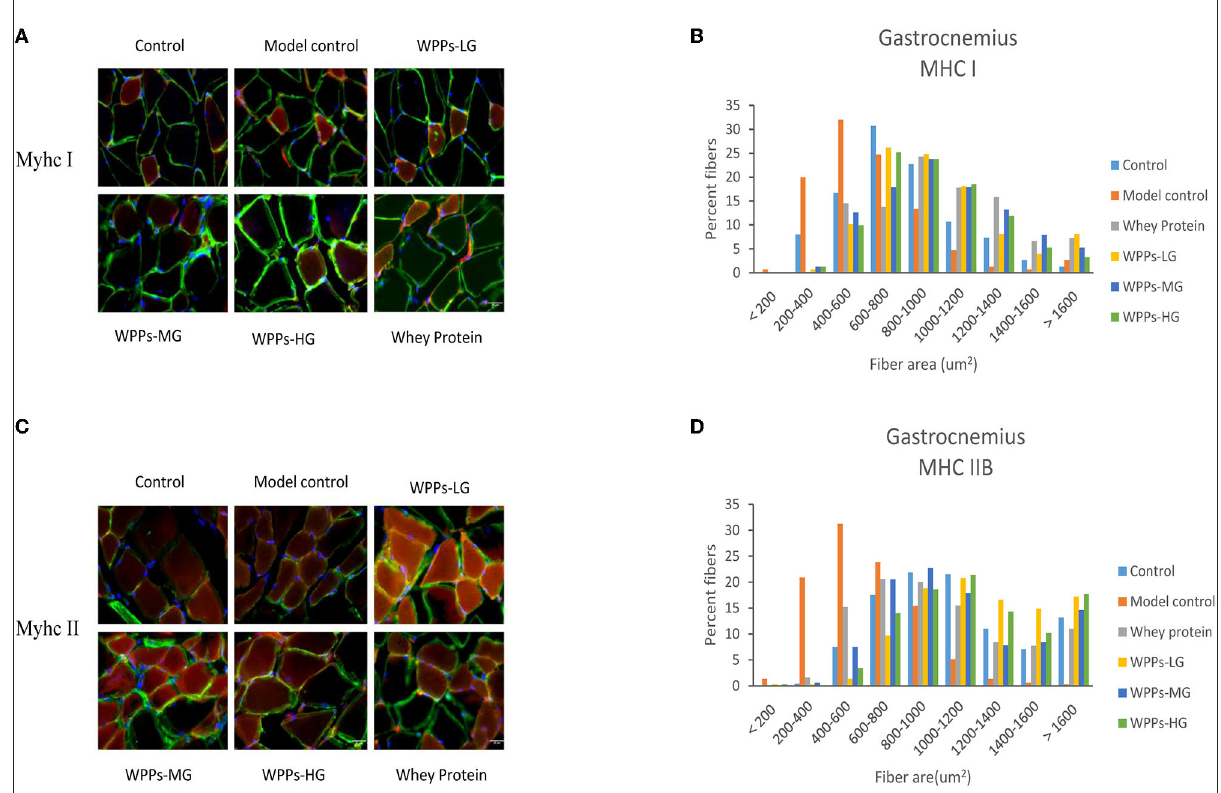
FIGURE5 Effects of WPPs on MyHC expression in mice ( n = 3). Representative images and quantification of laminin, MyHC I, and MyHC IIb immunofluorescent staining (red) in gastrocnemius ( n = 3) (A,C) . CSA distribution of MHC IIB fibers (gastrocnemius) and MHC I fibers (gastrocnemius) presented as frequency histograms (B,D)